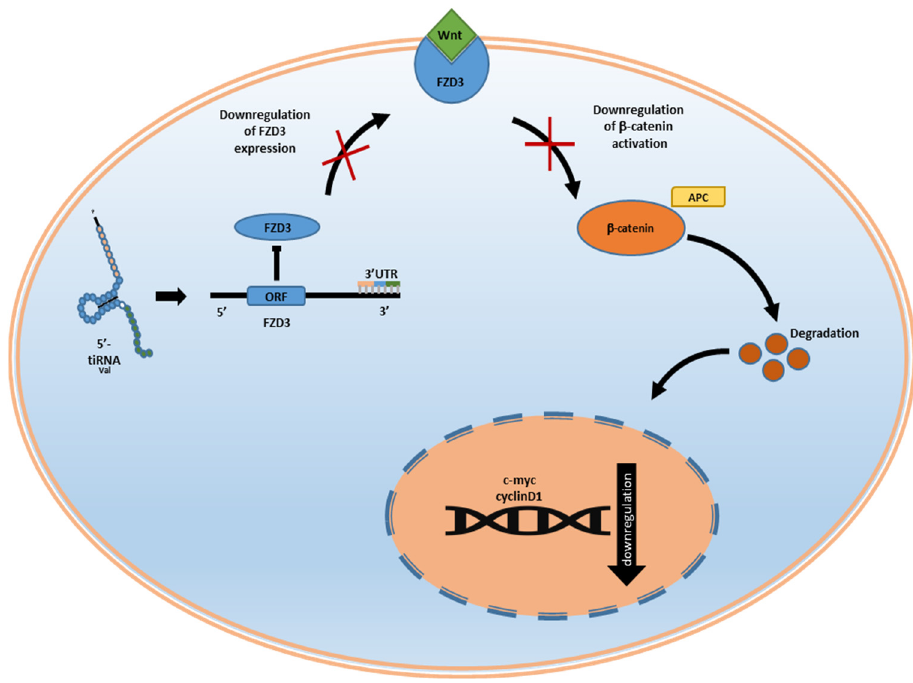
Figure 5. 5 ′ -tiRNA Val downregulates the Wnt/ β -catenin signalling pathway by targeting FZD3 gene expression.